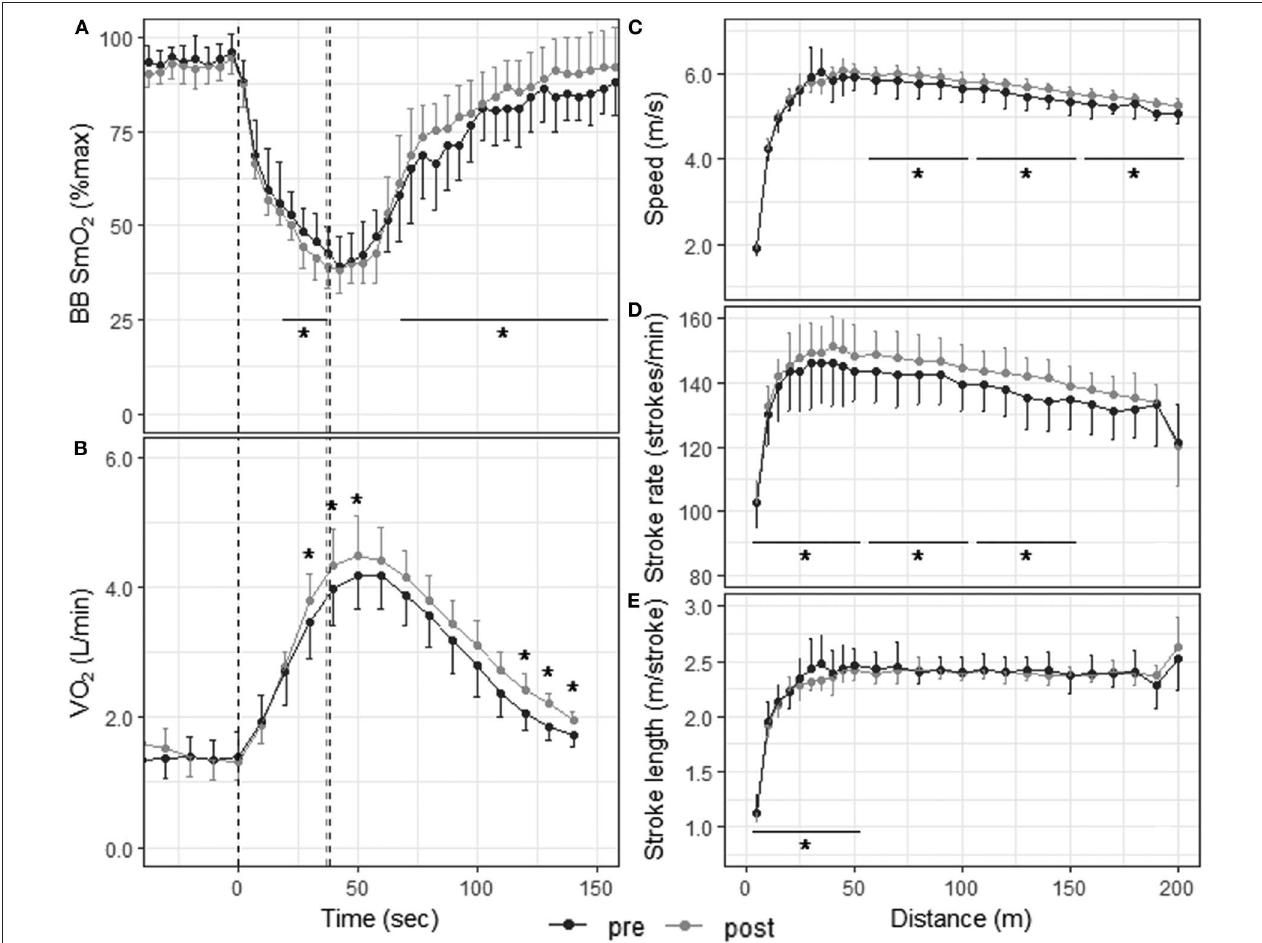
FIGURE 3 | Physiological responses and stroke parameters during the 200-m TT before and after the 3-weeks training camp. First vertical dashed line represents the start of the TT; second dashed line represents the end of the TT post-training and third dashed line the end of the TT pre-training. * p < 0.05 between pre- and post-training TTs. (A) Muscle oxygenation in the biceps brachii for 5-s segments 30s before, during, and 120s after the 200-m TT; (B) O 2 consumption for 10-s segments 30s before, during, and 120s after the 200-m TT; speed (C) , stroke rate (D) , and stroke length (E) for 5-m segments up to 50m and 10-m segments from 50 to